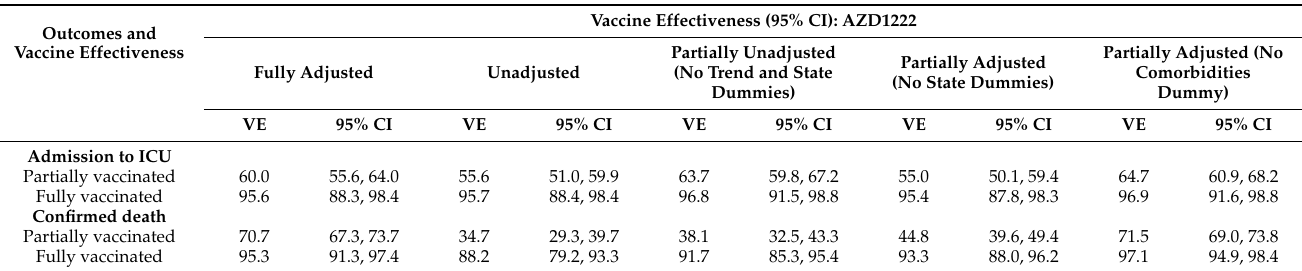
Table A3. Fully adjusted, partially adjusted, and unadjusted vaccine effectiveness in preventing admission to ICU and deaths among COVID-19 cases, according to vaccination status for AZD1222.